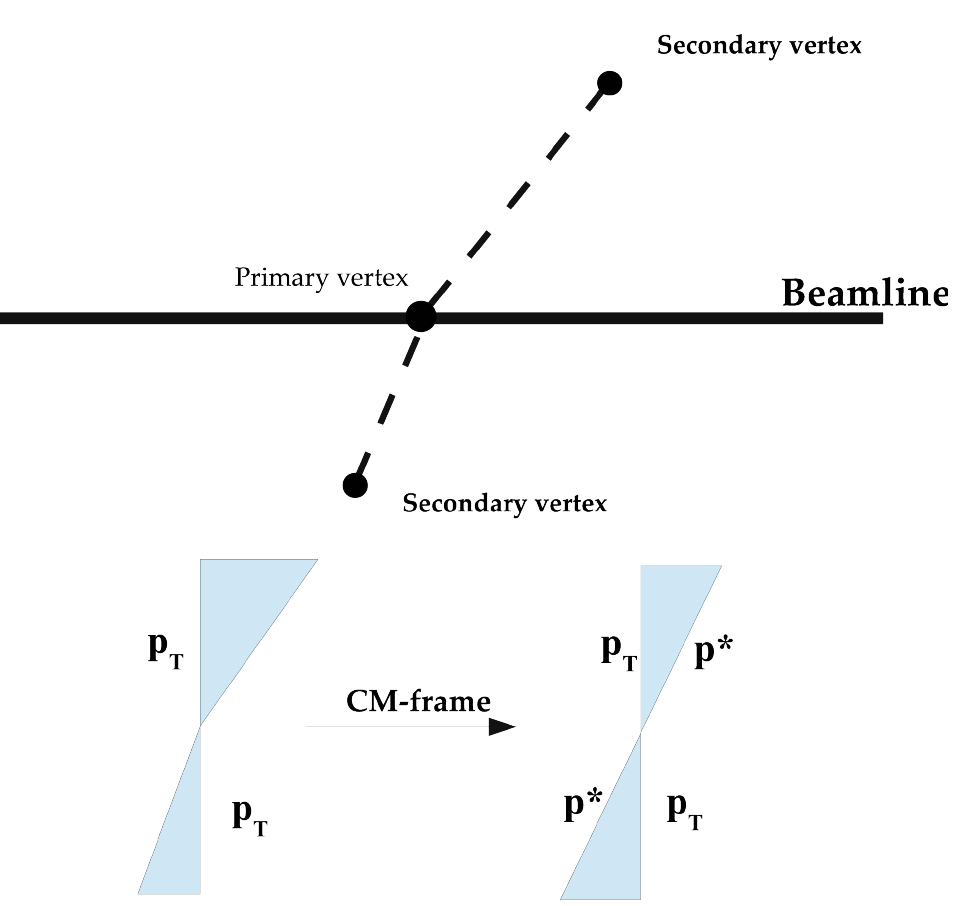
Figure 1 . The kinematics can be solved as shown. As the sneutrinos are neutral, their momentum vectors are aligned with the displacements of the secondary vertices from the primary vertex. We then construct the momenta in the lab frame by using these direction vectors and the fact that the transverse components are equal. Then we may boost to the center-of-mass frame, where we know the total momentum p ∗ drom eq.